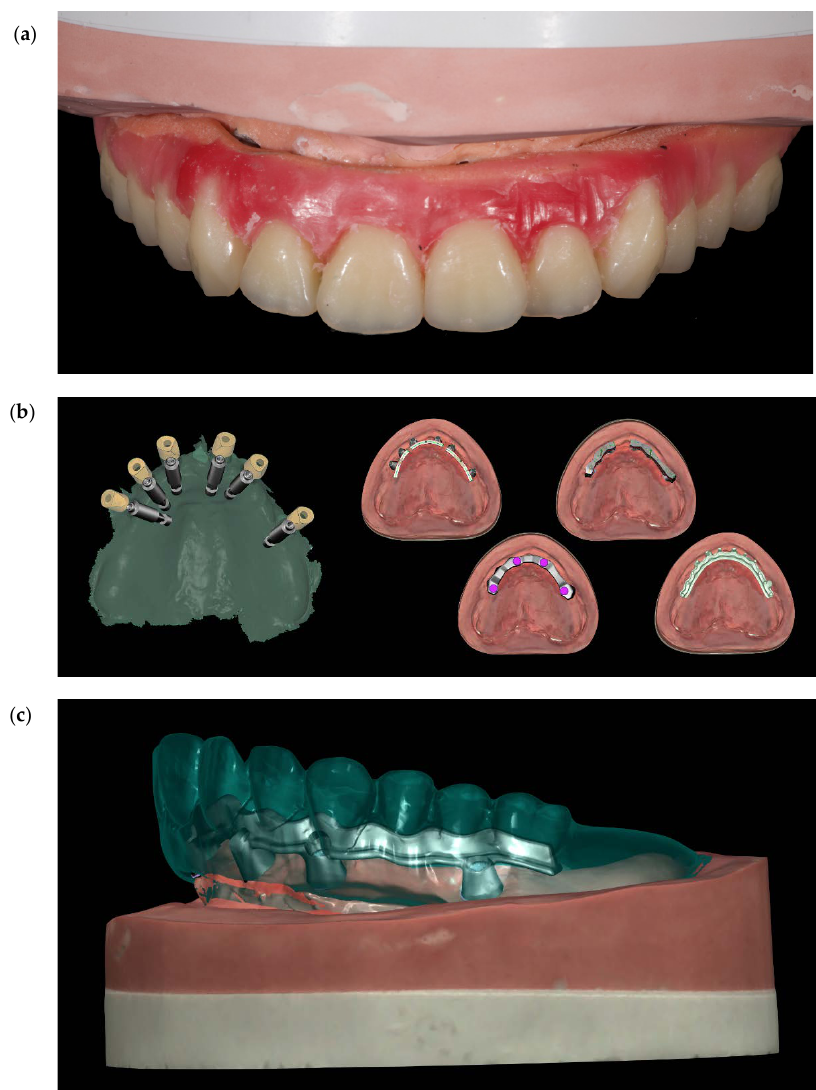
Figure 10. Vertical dimension of occlusion. Materials 2020 , 13 , x FOR PEER REVIEW